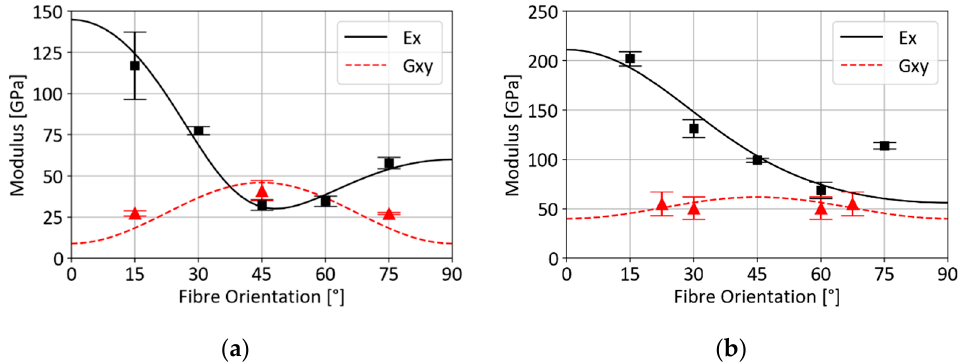
Figure 2. Comparison between the values of E x (black squares) and G xy (red triangles) with standard deviation obtained from tensile and shear tests and values evaluated from implementation of classical laminate theory on virtual UD plies for di ff erent fiber orientations for ( a ) C / C–SiC and ( b ) WHIPOX ™ .